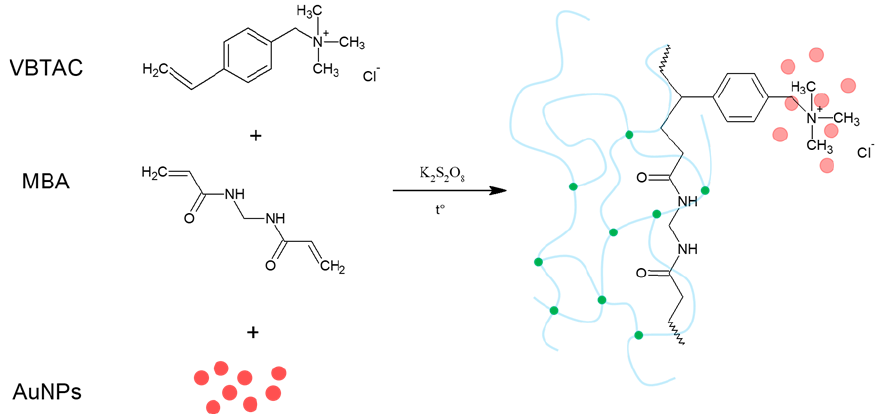
Figure 5. The synthesis route of VBTAC- co -MBA nanocomposite that could occur if the reaction environment contained only AuNPs dispersed in water.